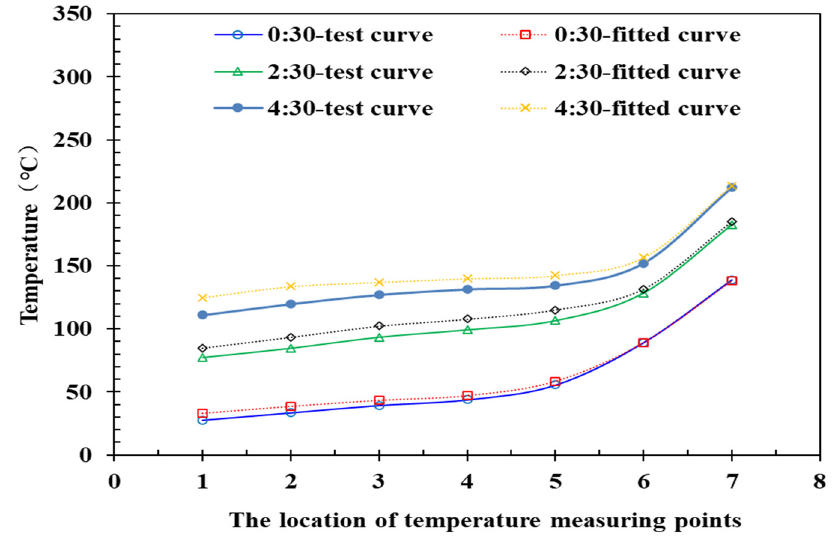
Figure 6. Temperature fitting results of saturated CO 2.